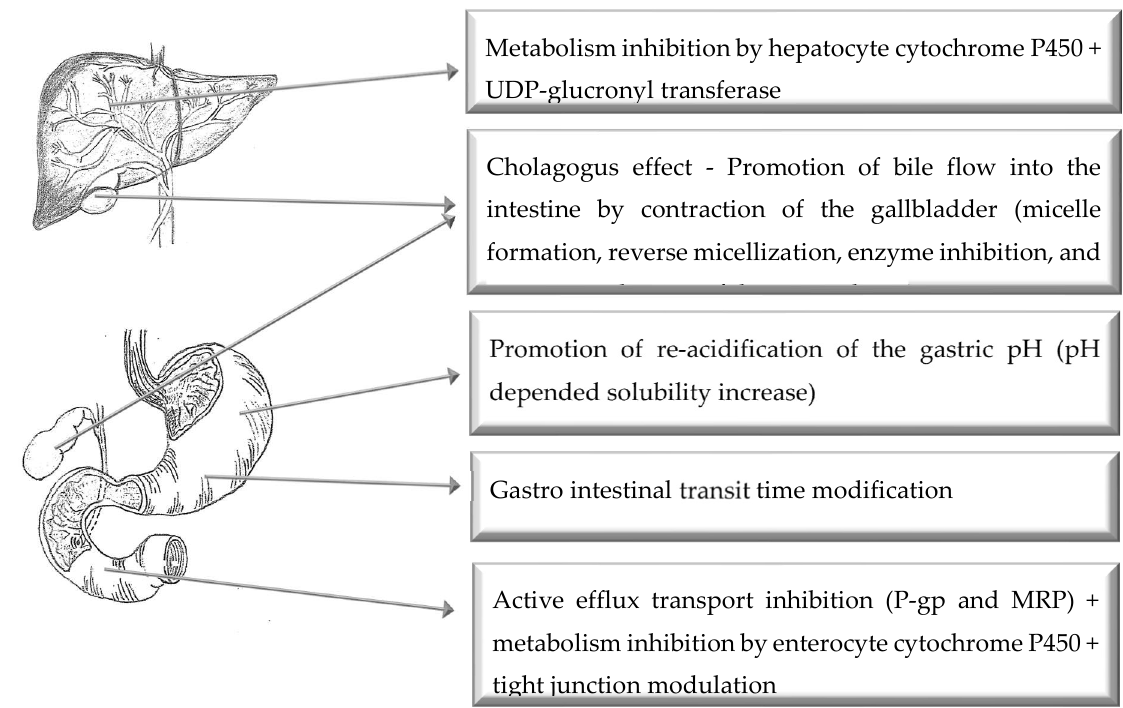
Figure 3. Illustration of the main mechanisms of action of bioenhancers for enhanced oral drug delivery.